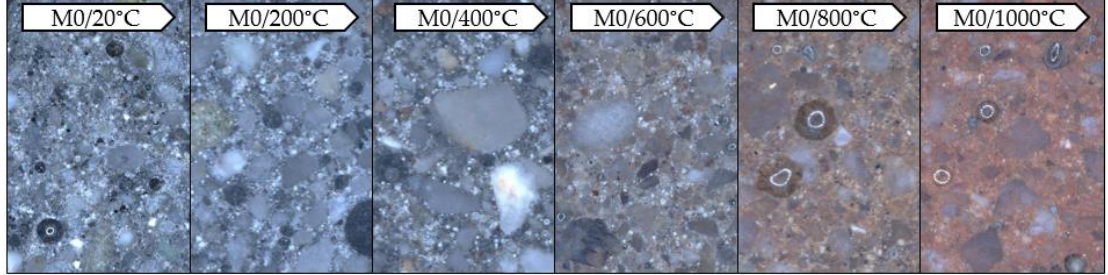
Figure 6. Photos taken with the Keyence VHX-7000 digital microscope, 50× magnification, mortar based on FA only.